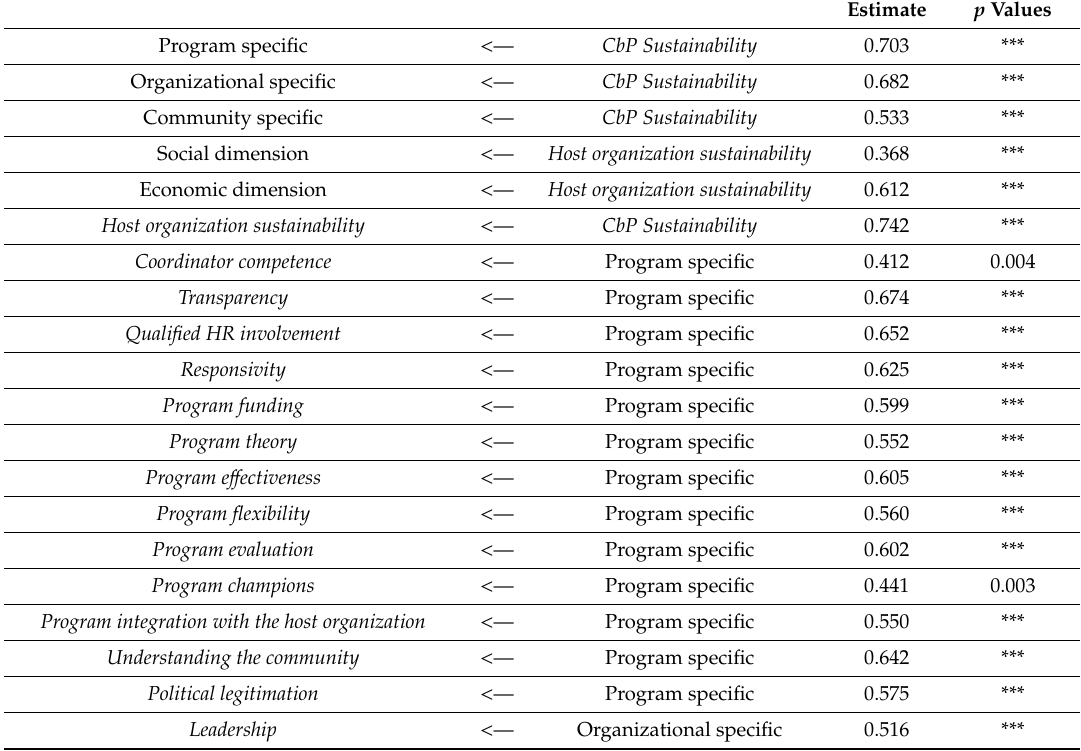
Table 9. Standardized regression weights: (complete Structural Equation Modeling